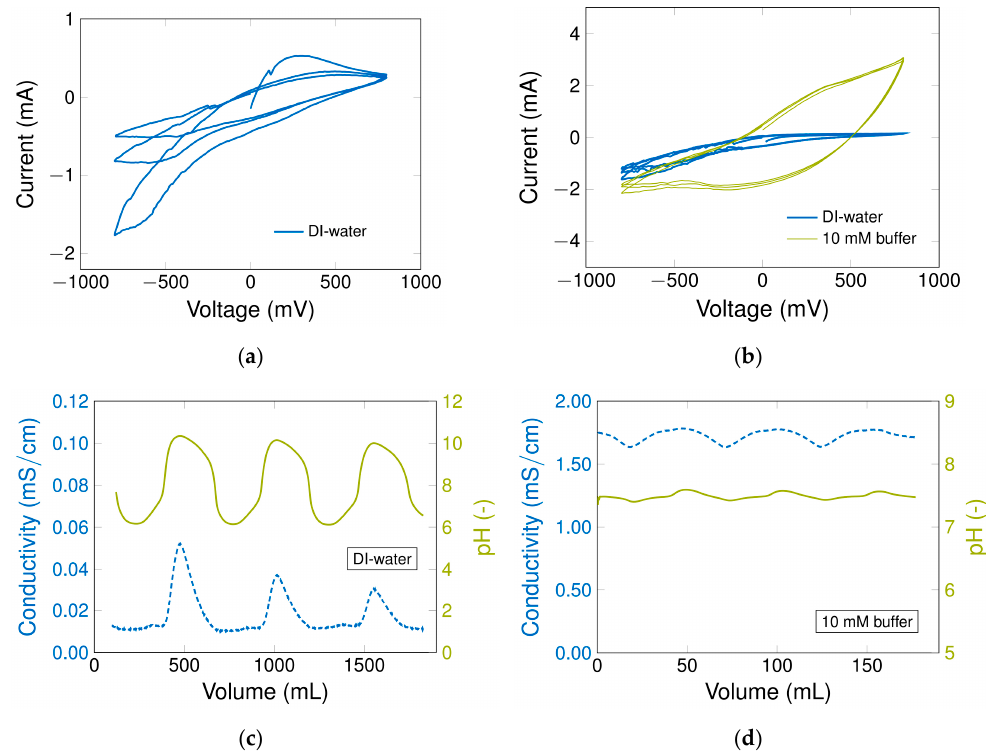
Figure 5. Cyclic voltammogram to compare two columns and two different mobile phases (1 mL/min). ( a ) Aging effect in a CNT-K column used with DI-water as the mobile phase (1 mV/s); ( b ) the current differences of DI-water (0.1 mV/s) and 10 mM phosphate buffer (1 mV/s) determined in another column B; ( c ) the cyclic potential’s influence on pH and conductivity using DI-water in column B; ( d ) the cyclic potential’s influence on pH and conductivity using 10 mM phosphate buffer in column B. The potential gradient increases from 0 mV to +800 mV; then decreases to − 800 mV; and increases again to +800 mV. The cycle is run three times and then stopped at 0 mV.